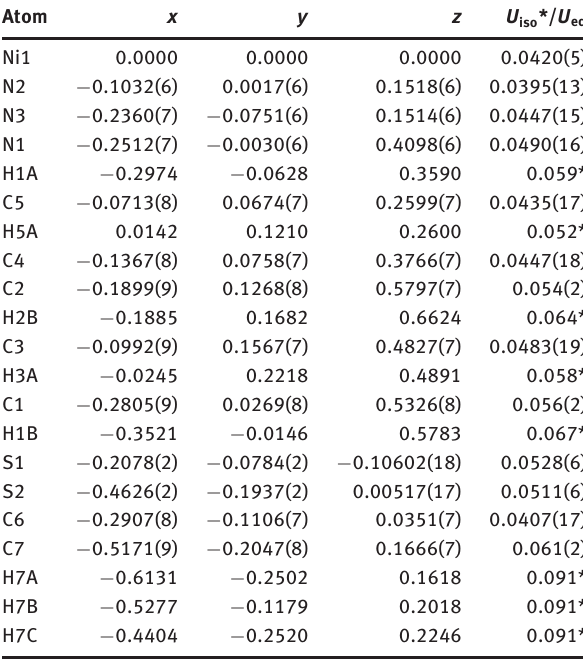
Table 2: Fractional atomic coordinates and isotropic or equivalent isotropic displacement parameters (Å 2